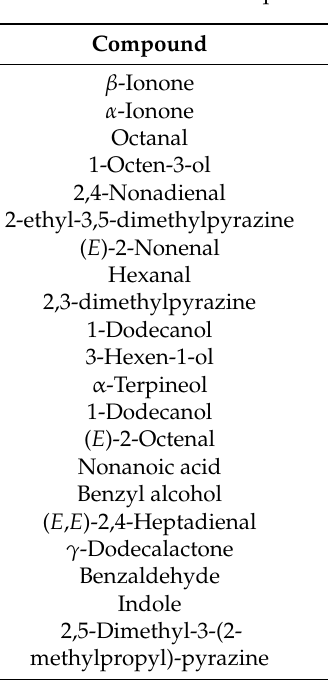
Table A13. Results of semi-quantification and calculated OAVs for sample